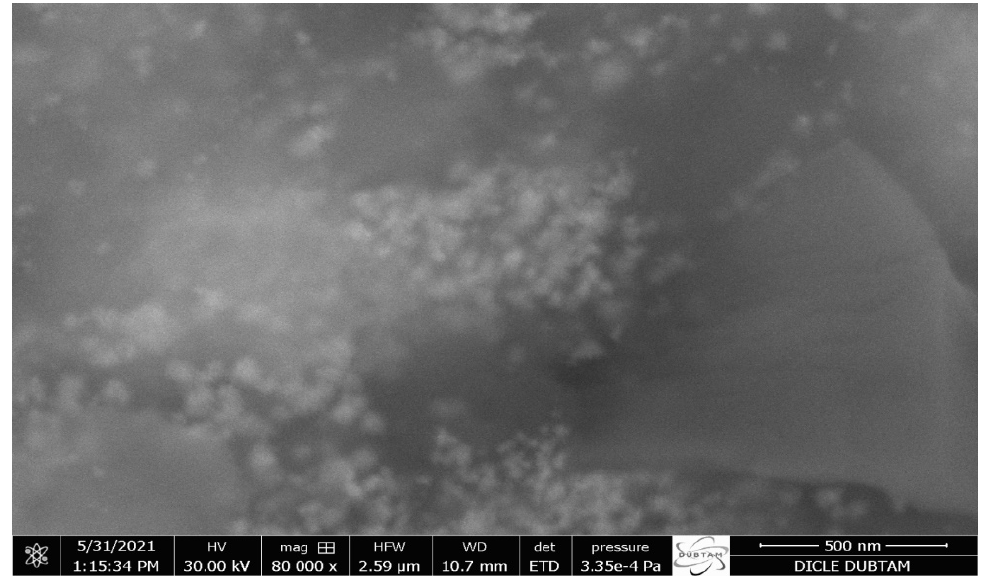
Figure 2. AC-AgNPs FE-SEM image at 500 nm scale.